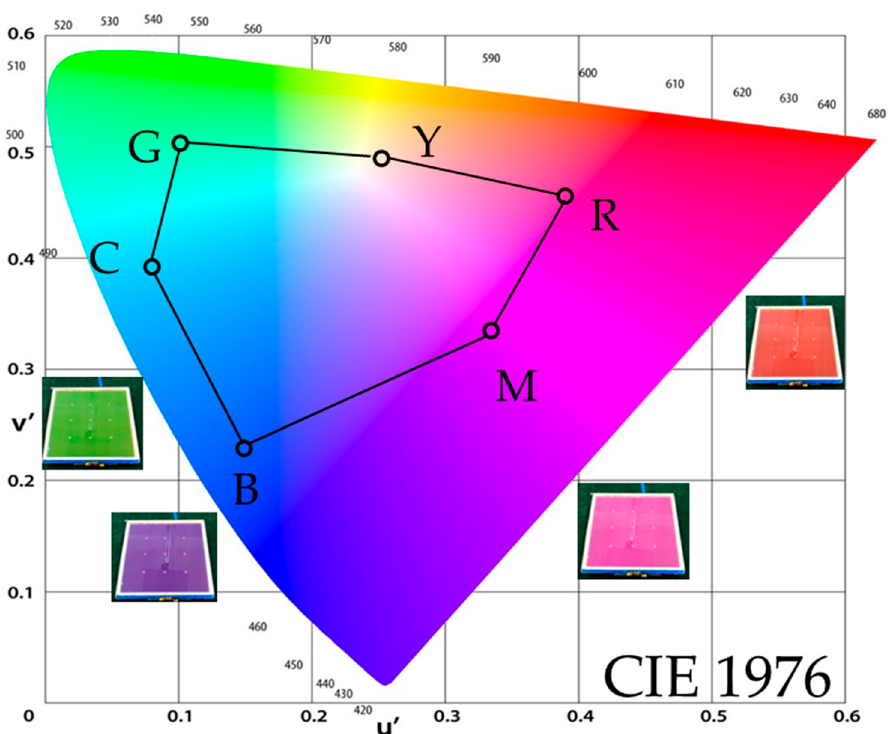
Figure 8. Color gamut in CIE 1976 measured by a spectroradiometer. The insets show pictures of red, green, magenta and cyan EWDs, respectively.